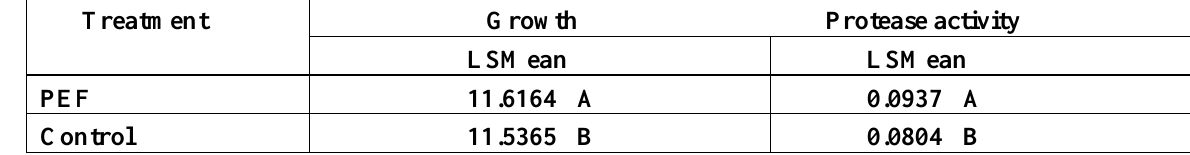
Table 2: Least square means for growth characteristics and protease activity of Streptococcus thermophilus as influenced by pulsed electric